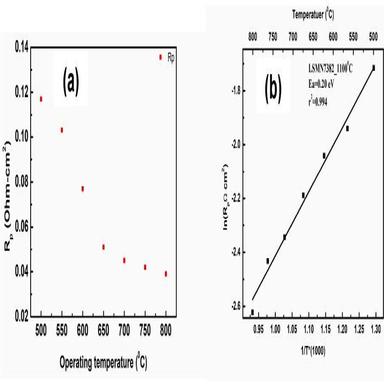
(a) Polarization resistance of LSMN7382 with respect to temperature and (b) the activation energy of ORR in the temperature range of 500–800 ◦C.